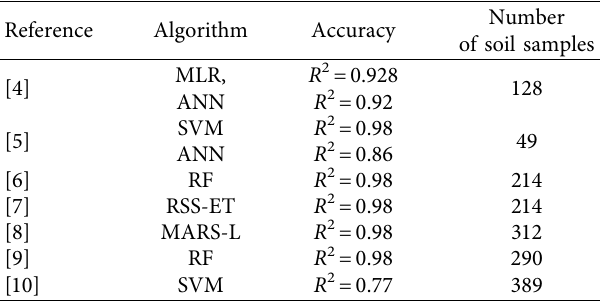
Table 1: Te related works used the ML model to predict the CBR of